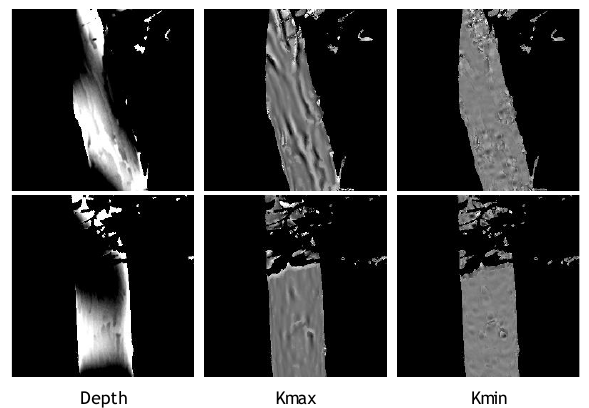
Figure 6. Stable creation of curvature images (top: cedar, bottom: